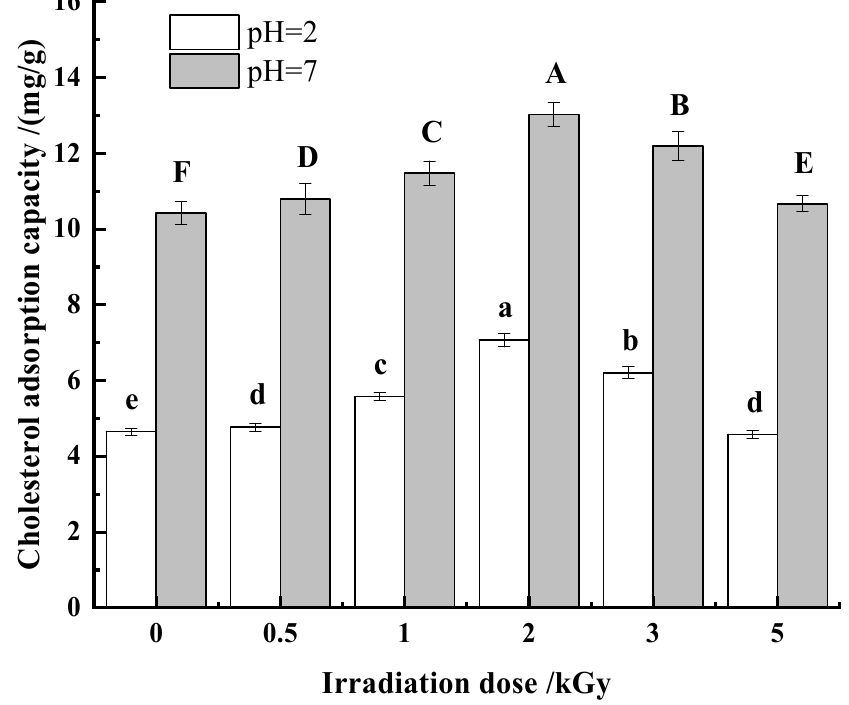
Figure 7. Effect of γ -irradiation on cholesterol adsorption of pea fiber. Note: Different uppercase letters indicate significant difference in cholesterol adsorption capacity under simulated gastric environment (pH = 2) ( p < 0.05), and different lowercase letters indicate significant difference in cholesterol adsorption capacity under simulated intestinal environment (pH = 7) ( p < 0.05).